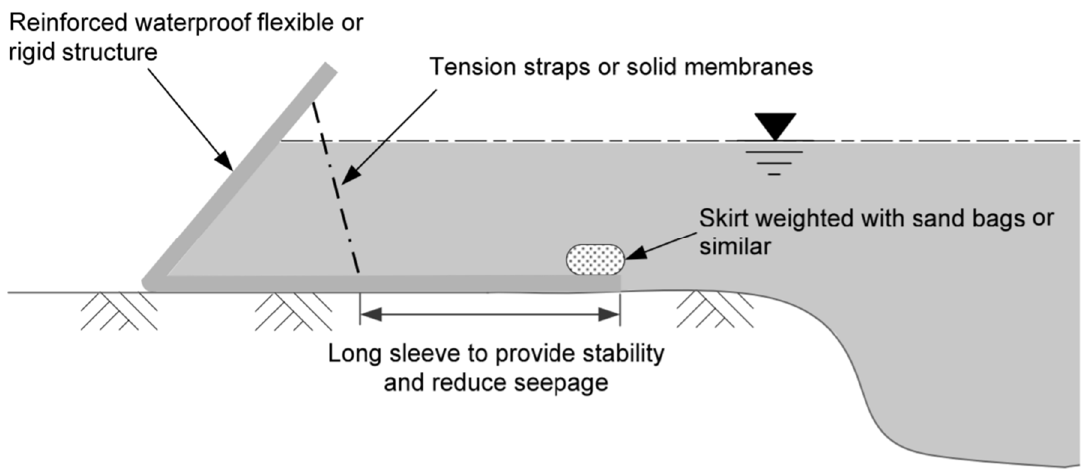
Figure A2. Free-standing barrier, derived from Ogunyoye et al. [15].